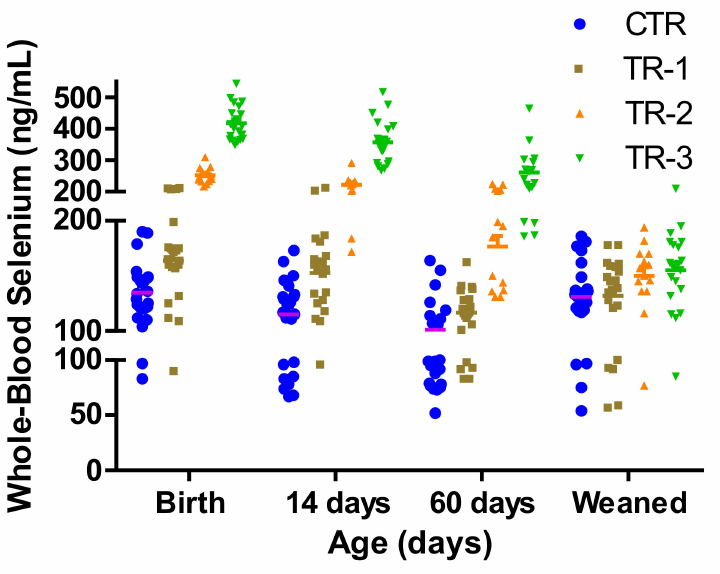
Figure 3. Whole-blood Se concentrations of individual calves measured at birth, 14 days, 60 days of age, and at weaning (6.5 to 8 months), from control cows and cows supplemented with Se- yeast boluses (105 mg Se/wk) during the first (TR-1), second (TR-2), and third (TR-3) trimester of gestation. Whole-blood Se concentrations < 50 ng/mL = clinical Se deficiency; WB-Se concentrations of 50–100 ng/mL below the reference range = subclinical Se deficiency; and WB-Se concentrations of 100–250 ng/mL (neonates) and 120–300 ng/mL (adults and growing calves) are in the reference range. A total of 11 of the 15 male CTR-calves, 6 of the 14 male TR-1 calves, 4 of the 8 female CTR calves, 3 of the 7 female TR-1 calves and 1 each of the 11 and 10 male TR-2 and TR-3 calves, respectively, during the repeated sampling times, had WB-Se concentrations below 100 ng/mL (Figure 3). As the time span between maternal Se supplementation and sampling increased, a larger number of TR calves became subclinically deficient (from two TR calves in the first 14 days to 11 TR calves during latter sampling times; McNemar test: p =